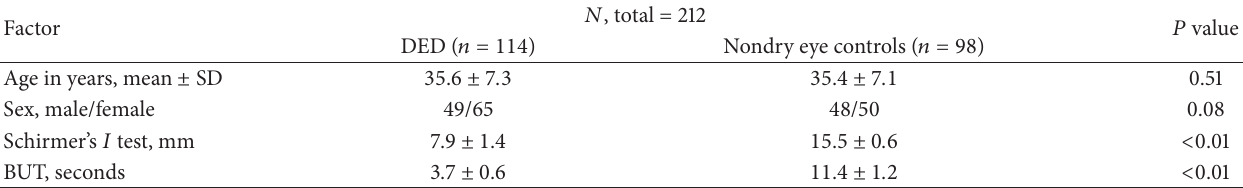
Figure 2: Distribution of C. trachomatis , M. hominis , and U. urealyticum infections in the DED group and nondry eye controls ( 𝑛 (%)). Statistical analysis showed a significant difference between the two groups with regard to the frequency of detection of (1) each of the three pathogens ( 𝑃 < 0.01 ) and (2) their mixed infections ( 𝑃 < 0.01 ). Table 1: Characteristics of patients in the dry eye disease group and control